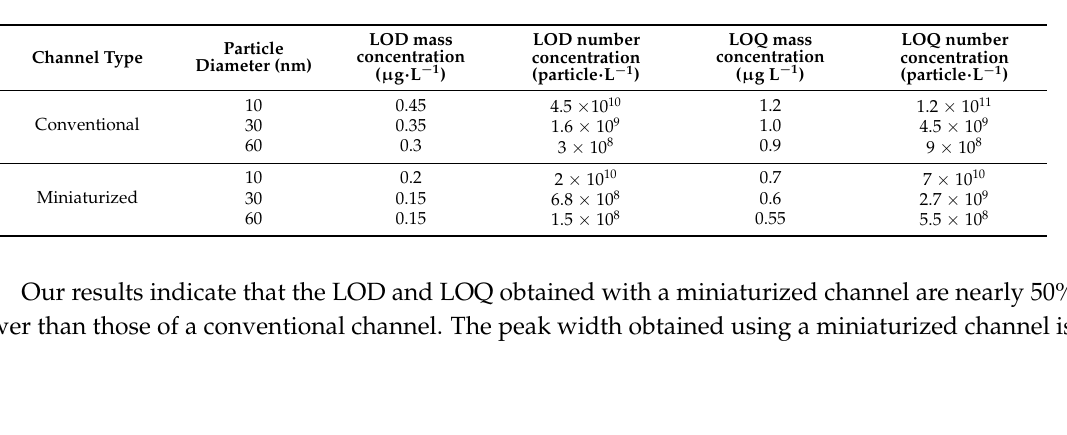
Table 8. Comparison of LOD and LOQ for gold nanoparticle mixture obtained with both channels (single